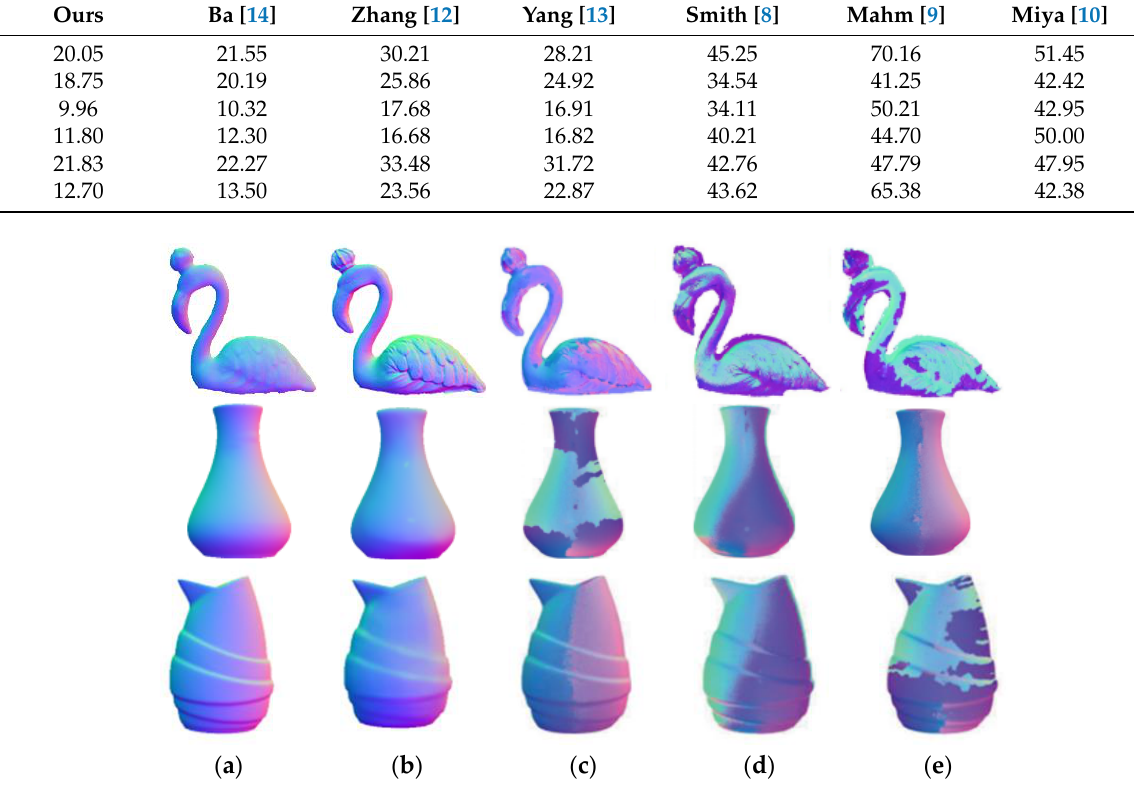
Figure 12. Comparison with traditional algorithms for estimating normal vectors. ( a ) True; ( b ) Ours; ( c ) References [12,13]; ( d ) Reference [9]; ( e ) Reference [10].